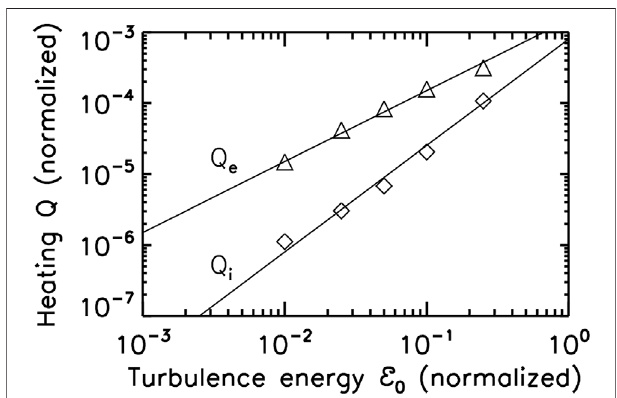
FIGURE 4 | Heating rate Q for electrons and ions as a function of the magnetic fl uctuation energy E 0 at the initial time obtained from the 3D PIC simulations by Gary et al. [56]. The power-law fi tting yields empirical scaling of Q e (cid:3) 0 . 0015 E 0 for the electrons and Q i (cid:3) 0 . 0008 E 3/2 0 for the